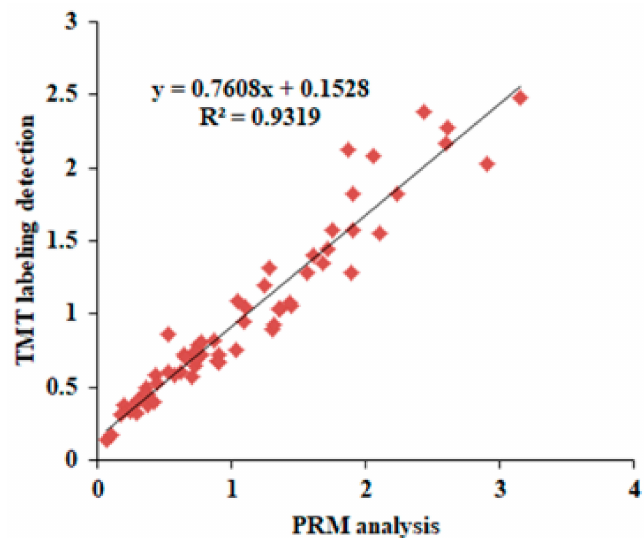
Figure 3. Validation of di ff erentially expressed proteins by parallel reaction monitoring (PRM). Correlation of fold change analyzed by tandem mass tags (TMT) labelling detection platform ( y axis) with the data obtained by PRM reaction ( x